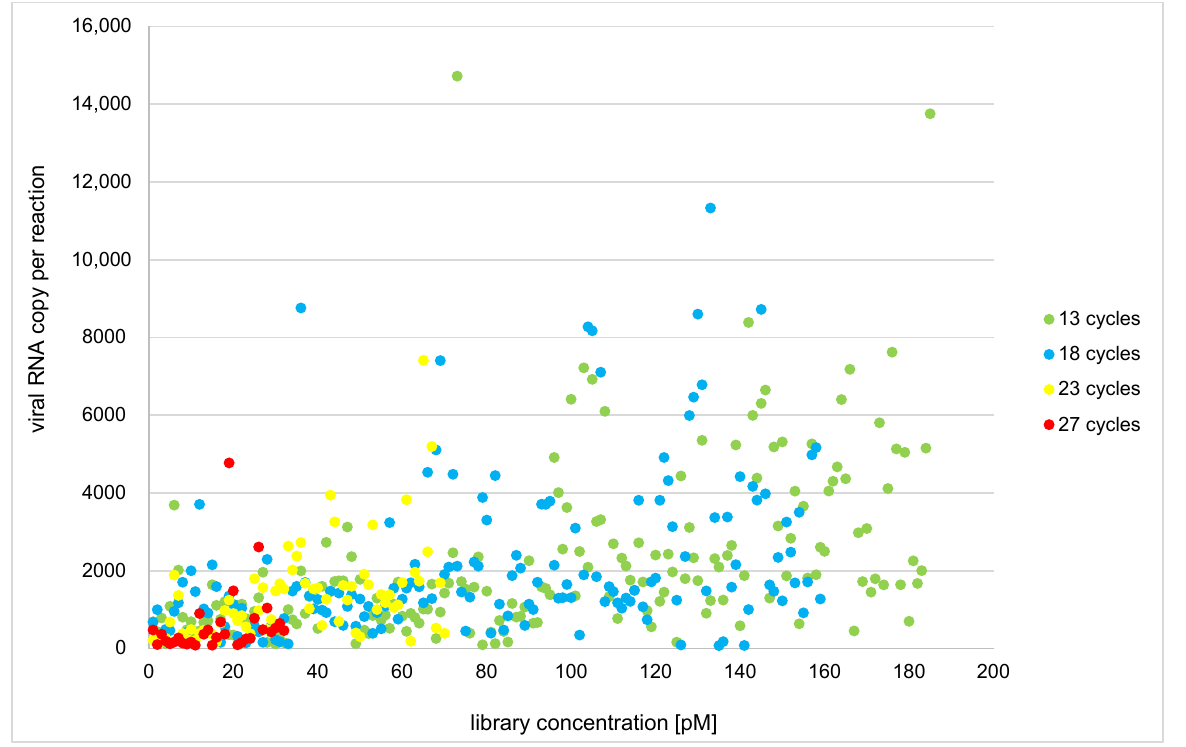
Figure 1. Correlation between initial RNA input and library construction with regard to the number of amplification cycles (no-normalization group and no library reamplification). The no-normalization protocol produced optimal library concentration for samples with higher C T values (the number of cycles in which the N-gene fluorescence signal ex- ceeded 10,000 units), and thus lower initial RNA input; the mean N gene C T for samples that generated libraries ≥ 70 pM was 21.5 in the no-normalization group and 18.7 for the normalization group (Table 1). Table 1. Overview of samples subjected to library construction, amplification protocols, and quality of constructed libraries.